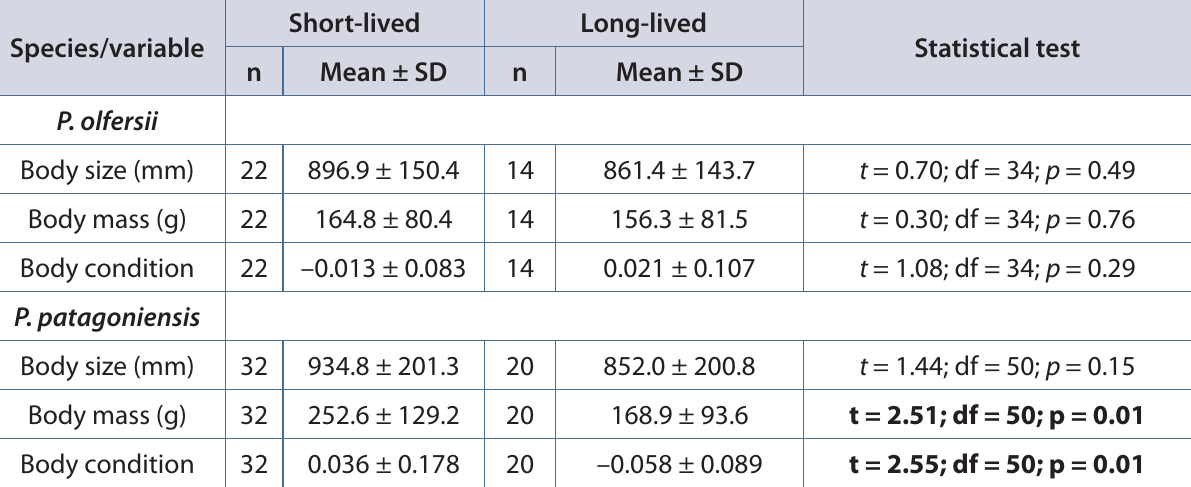
Table 1. Mean body measurements at admission for long-lived (over three months) and short-lived individuals (under three months). Values in bold indicate significant differences between long and short- lived